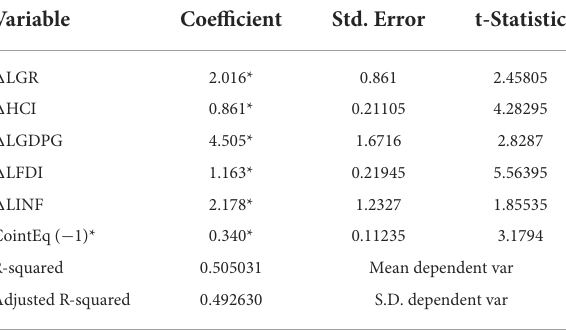
TABLE 9 Short run